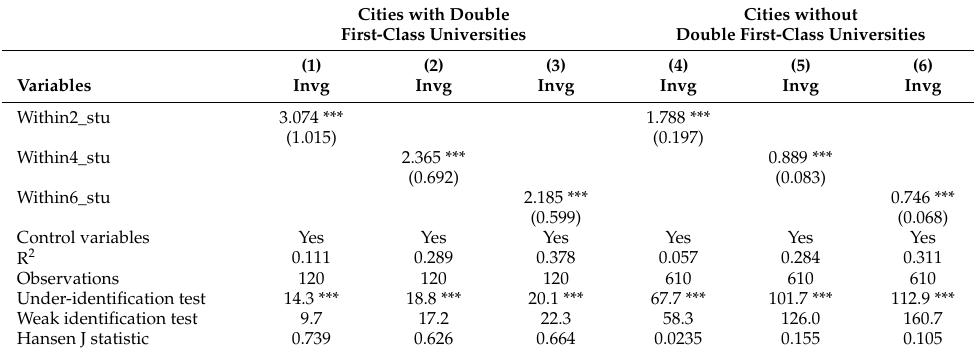
Table 7. The heterogeneous impact of double first-class university on invention patents granted: university student ratio.